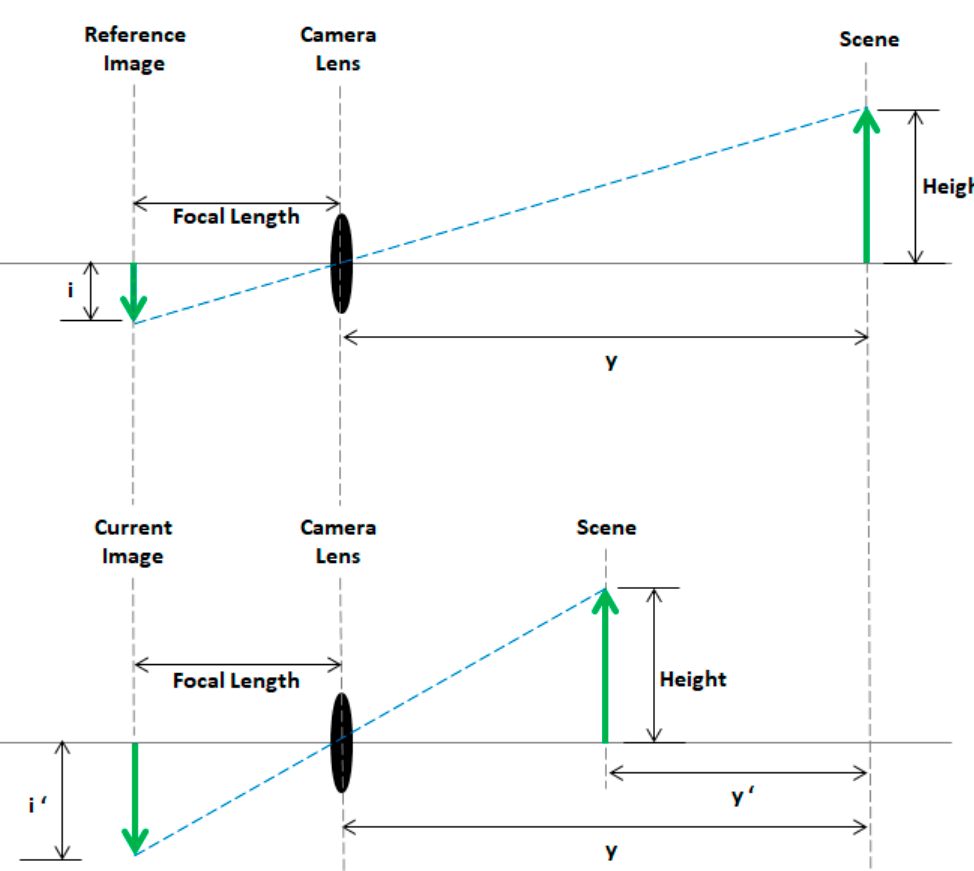
Figure 14. The method used to calculate the camera distance to the scene (adapted from [57]).